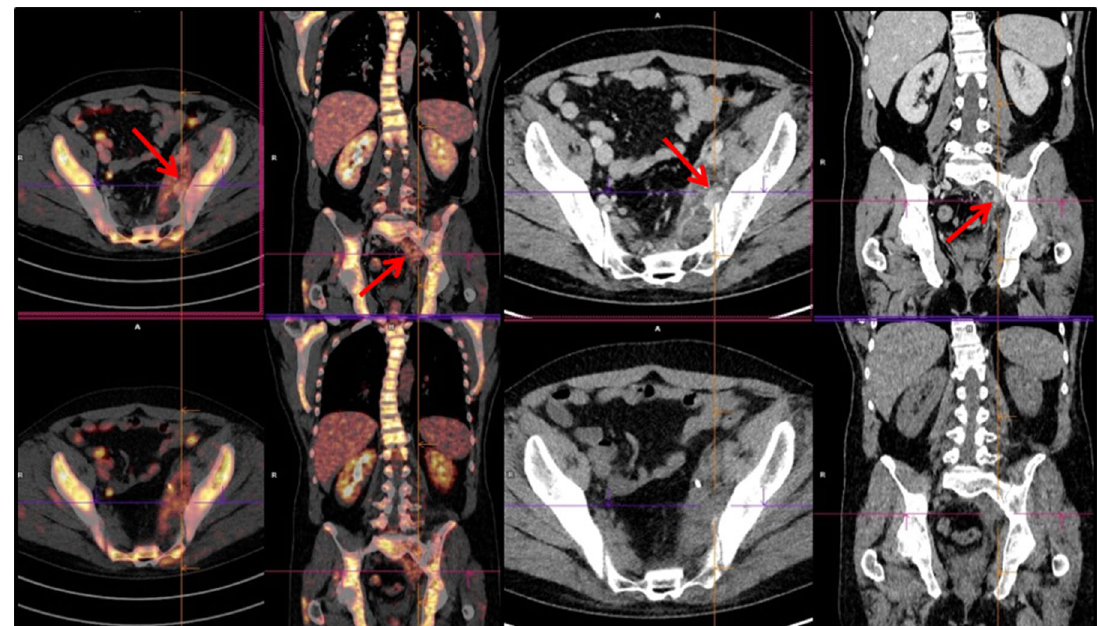
Figure 3. PET/ceCT showed additional nodal lesions in the left iliac region [DS 3; SUVmax 2.3].